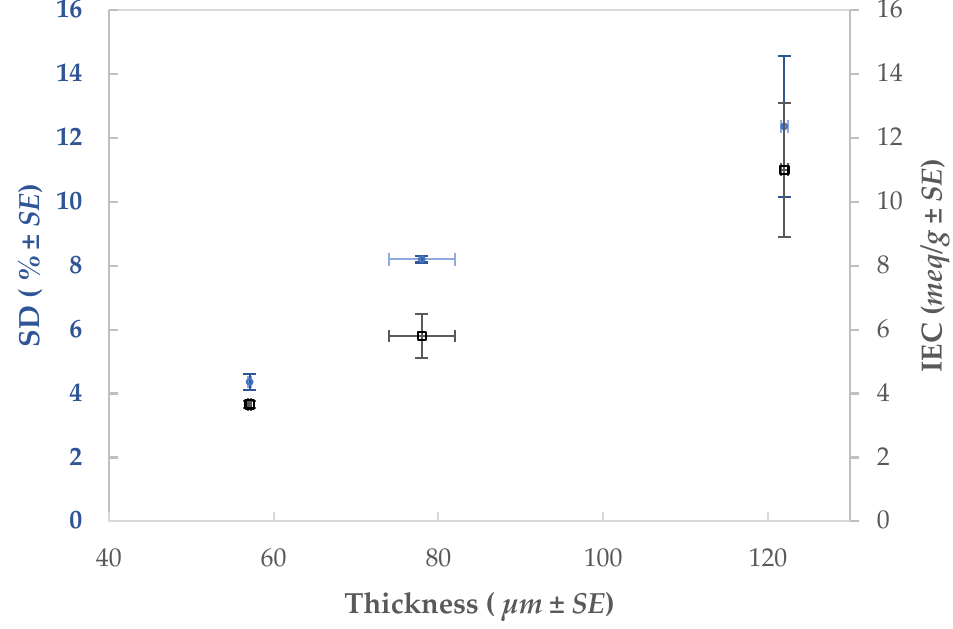
Figure 5. SD and IEC as functions of the membrane thickness for the AEM-HT baseline membrane.